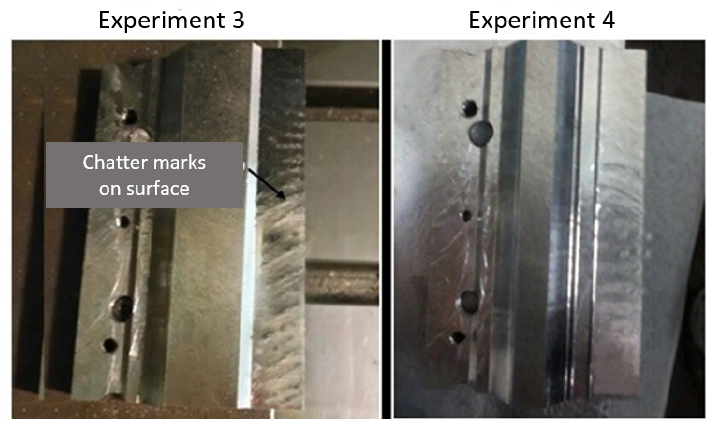
Fig. 11. Workpiece after milling of gray cast iron